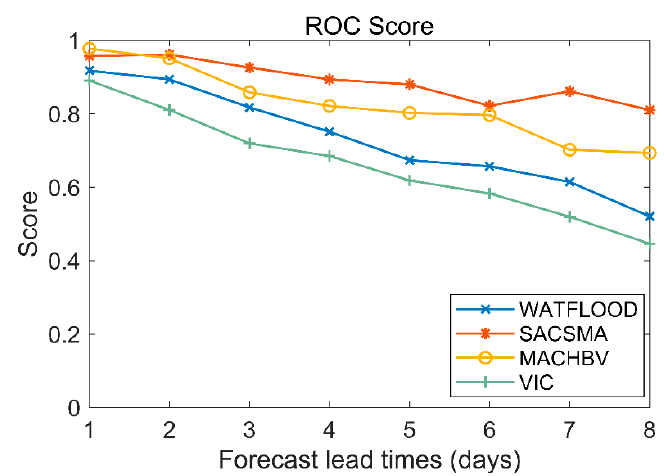
Figure 11. The ROC score measured by the Area Under the ROC Curves of four hydrological models.